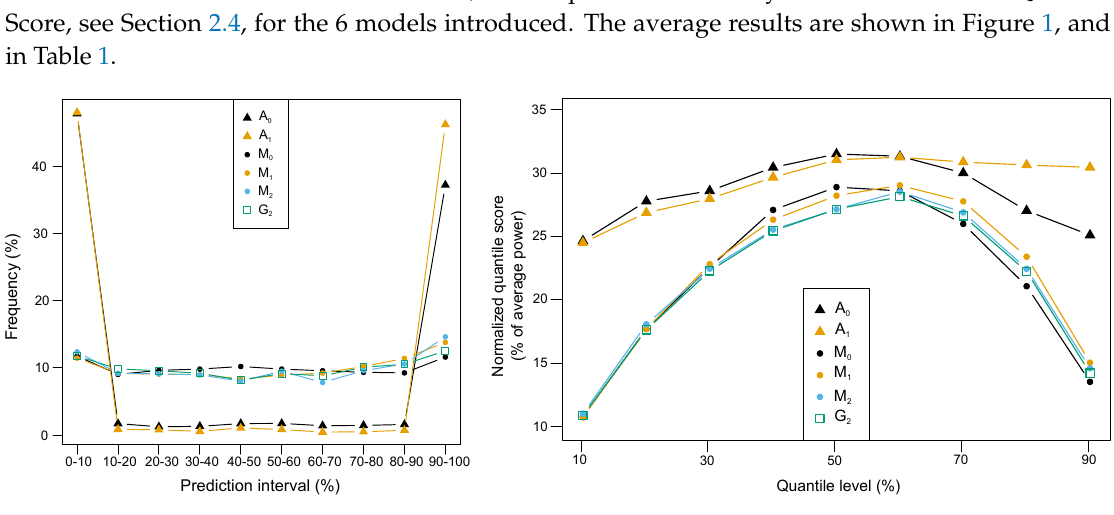
Figure 1. Reliability graph ( left figure) and quantile score curves ( right figure) for the 6 models in the selected subset Ξ . Table 1. Median performance indices (in %) and reliability ratio for various day-ahead forecasting models among the subset Ξ